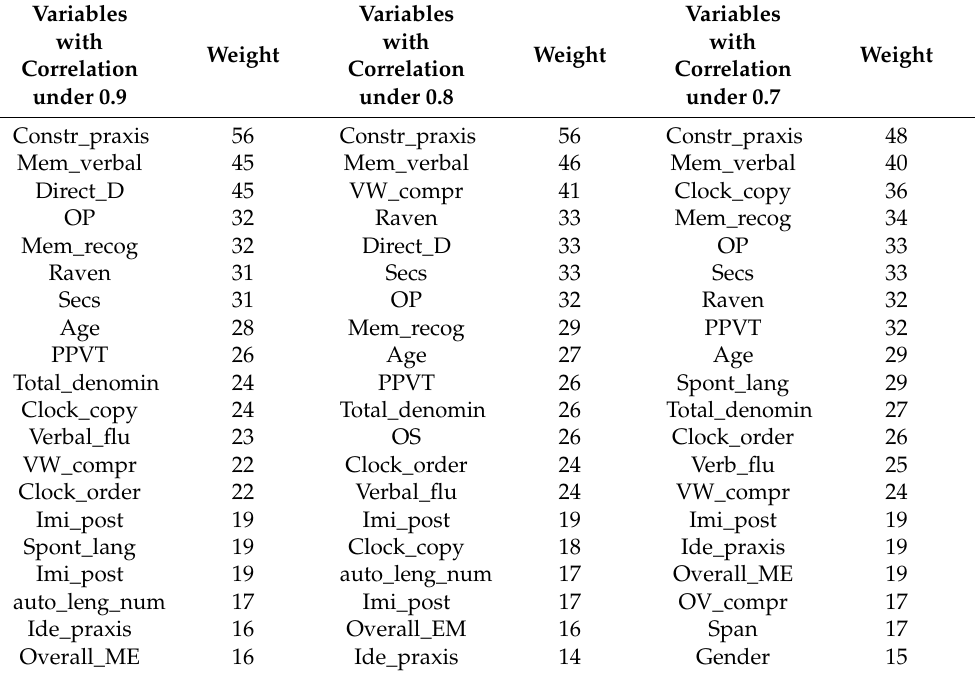
Table 7. Automatic selection of variables important for EF prediction based on weights.